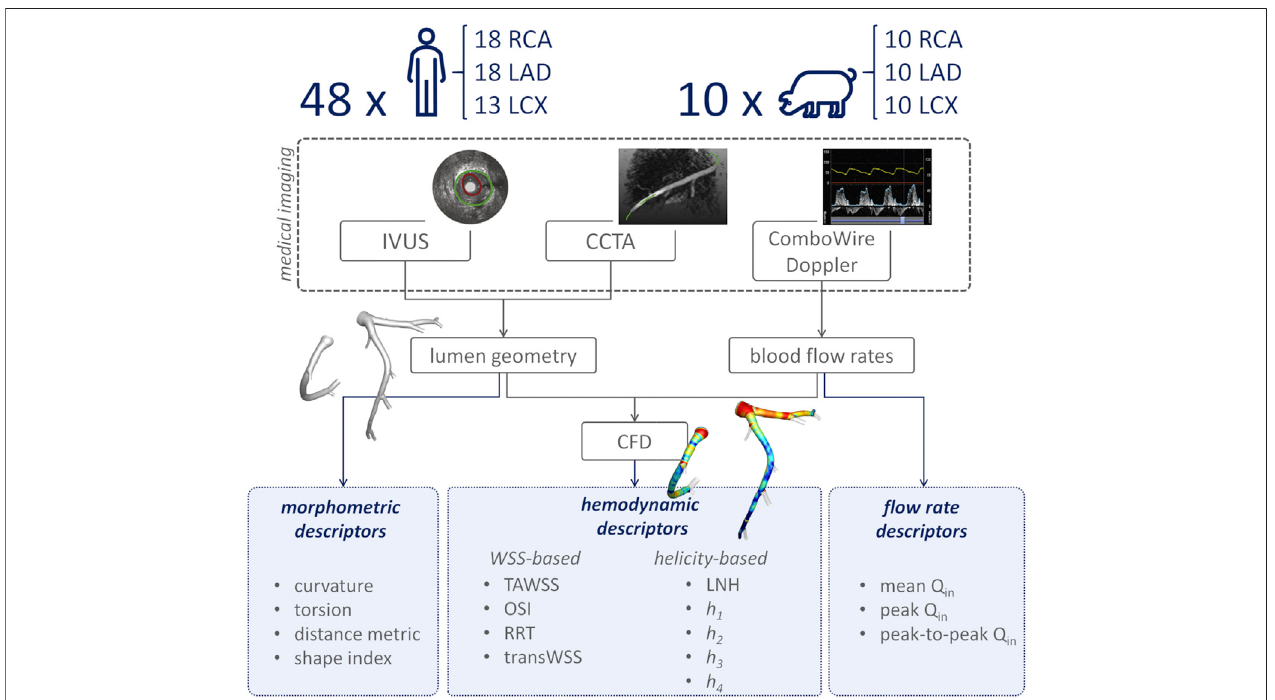
FIGURE 1 | Schematic diagram of the study design, showing how imaging data contribute to de fi ne vessel geometry and hemodynamic, morphometric, and fl ow variables. RCA, LAD, and LCX denote right, left anterior descending, and left circum fl ex coronary artery, respectively. IVUS: intravascular ultrasound; CCTA: coronary computedtomographyangiography;CFD:computational fl uiddynamics;TAWSS: time-averaged wallshearstress;OSI:oscillatory shearindex;RRT:relativeresidence time;transWSS:transversewallshearstress;LNH:localnormalizedhelicity; h 1 :averagehelicity; h 2 :averagehelicityintensity; h 3 :signedbalanceofcounterrotating helical fl ow structures; h 4 : unsigned balance of counter rotating helical fl ow structures; Q in : in fl ow